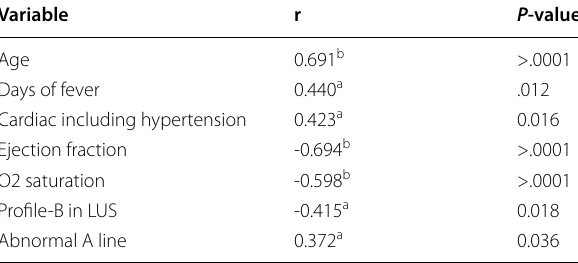
Table 4 Correlation in COVID-19 positive patients